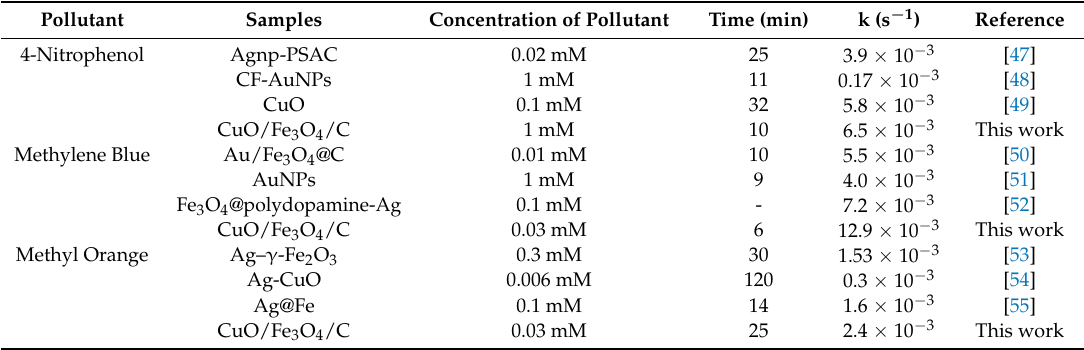
Table 1. Comparison of the catalytic performance for the reduction of 4-nitrophenol, methylene blue (MB), and methyl orange (MO) using the carbon-doped CuO/Fe 3 O 4 composite catalyst and other reported catalysts in the literature.